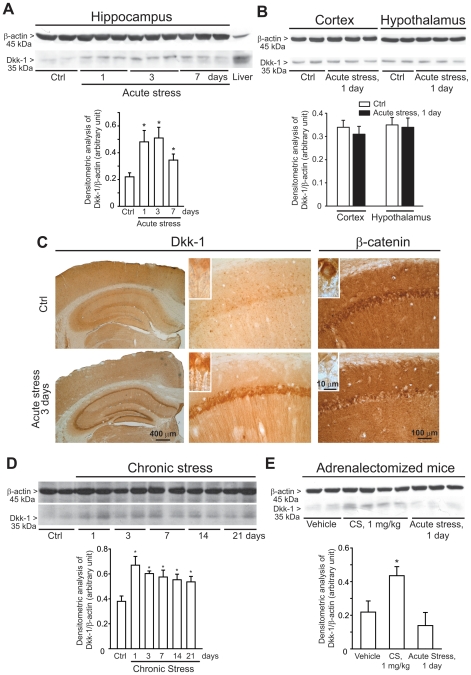
Induction of Dkk-1 in the hippocampus of CD1 mice exposed to acute or chronic restraint stress.A representative immunoblot of Dkk-1 in hippocampal extracts of mice at 1, 3 or 7 days following a single exposure to mild restrain stress (“acute stress”) is shown in (A). Data are means ± S.E.M. of 6–9 individual determinations. *p<0.05 (One-way ANOVA + Fisher's PLSD vs. Control (Ctrl) mice. A representative immunoblot of Dkk-1 in extracts from cortex and hypothalamus of mice at 1 day following a single exposure to mild restrain stress (“acute stress”) is shown in (B). Data are means ± S.E.M. of 5-6 individual determinations. Immunohistochemical analysis of Dkk-1 and â-catenin in control mice and mice killed 3 days after acute stress is shown in (C). Note the lack of Dkk-1 immunostaining in cell nuclei in the inset at high magnification. Immunoblot analysis of Dkk-1 in mice exposed to repeated episodes of mild restrain stress (once a day for 21 consecutive days) (“chronic stress”) is shown in (D). Mice were killed 24 h after the last exposure to stress at day 1, 3, 7, 14, and 21 (i.e. mice were killed at day 2, 4, 8, 15, and 22). Values are means ± S.E.M. of 6–9 determinations. *p<0.05 (One-way ANOVA + Fisher's PLSD) vs. controls. Immunoblot analysis of Dkk-1 levels in the hippocampus of adrenalectomized mice injected with vehicle or corticosterone (CS, 1 mg/kg, s.c.) or exposed to acute stress is shown in E. The group of adrenalictomized mice was also injected with vehicle to allow comparisons with the two previous groups. Mice were killed 24 h after treatments. Values are means ± S.E.M. of 6–7 determinations. *p<0.05 (One-way ANOVA + Fisher's PLSD) vs. unstressed mice injected with vehicle.